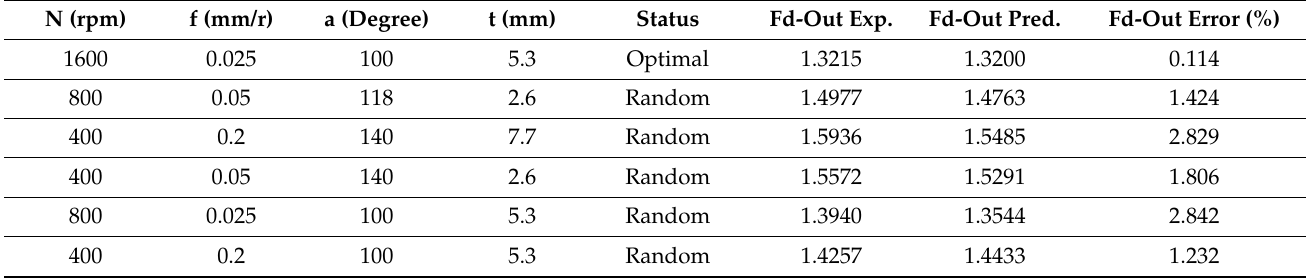
Table 11. Verification of the results for Fd −